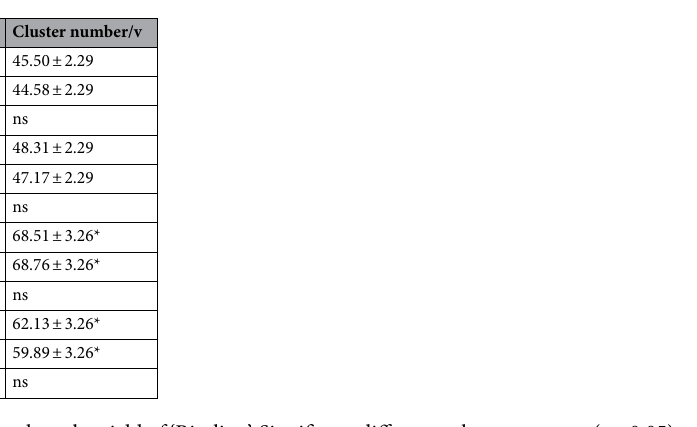
Table 4. Effect of lateral removal on the yield of ‘Riesling’. Significant differences between years ( p < 0.05) are designated by *.